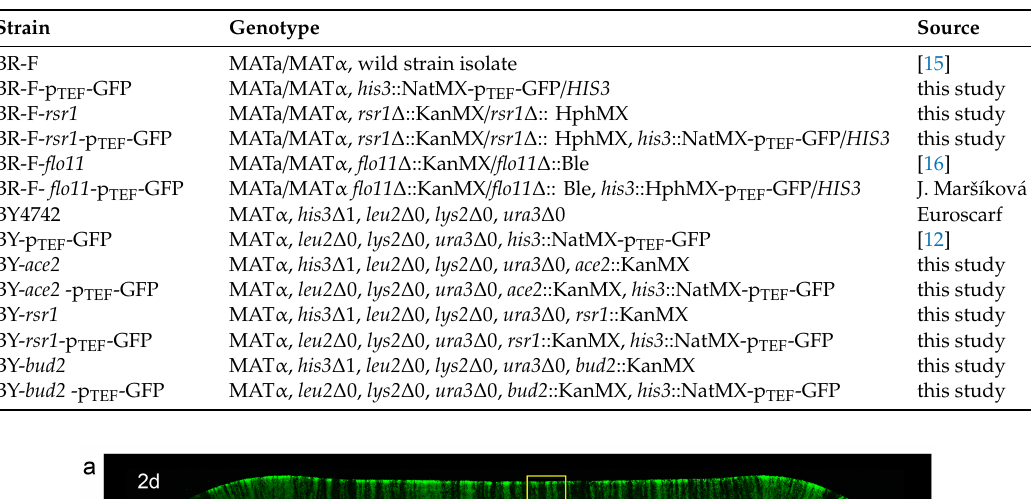
Table 1. Strains used in this study.